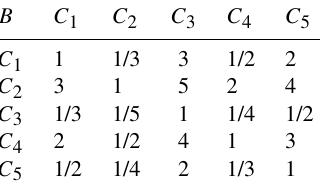
Table 7. The results of elementary dependent function for every grade.